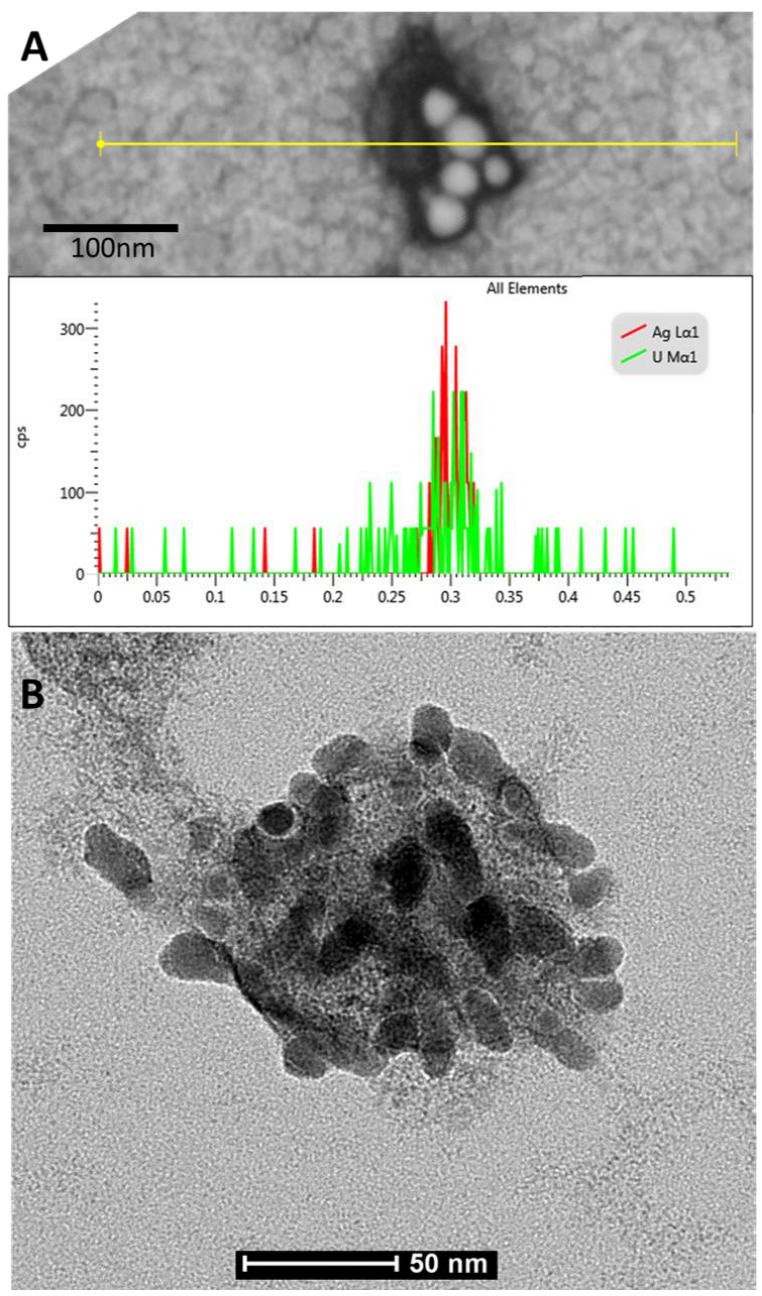
Figure 2. ( A ) The ultrastructure of Herpes simplex virus-2 (HSV-2) with attached several AgNP particles and EDX spectra of silver and uranium aligned with observed objects, acquired using the line-scan mode; scanning-transmission electron microscope, scale bar = 100 nm. ( B ) The ultrastructure of HSV-2 covered with silver nanoparticles; transmission electron microscope, scale bar = 50 nm.